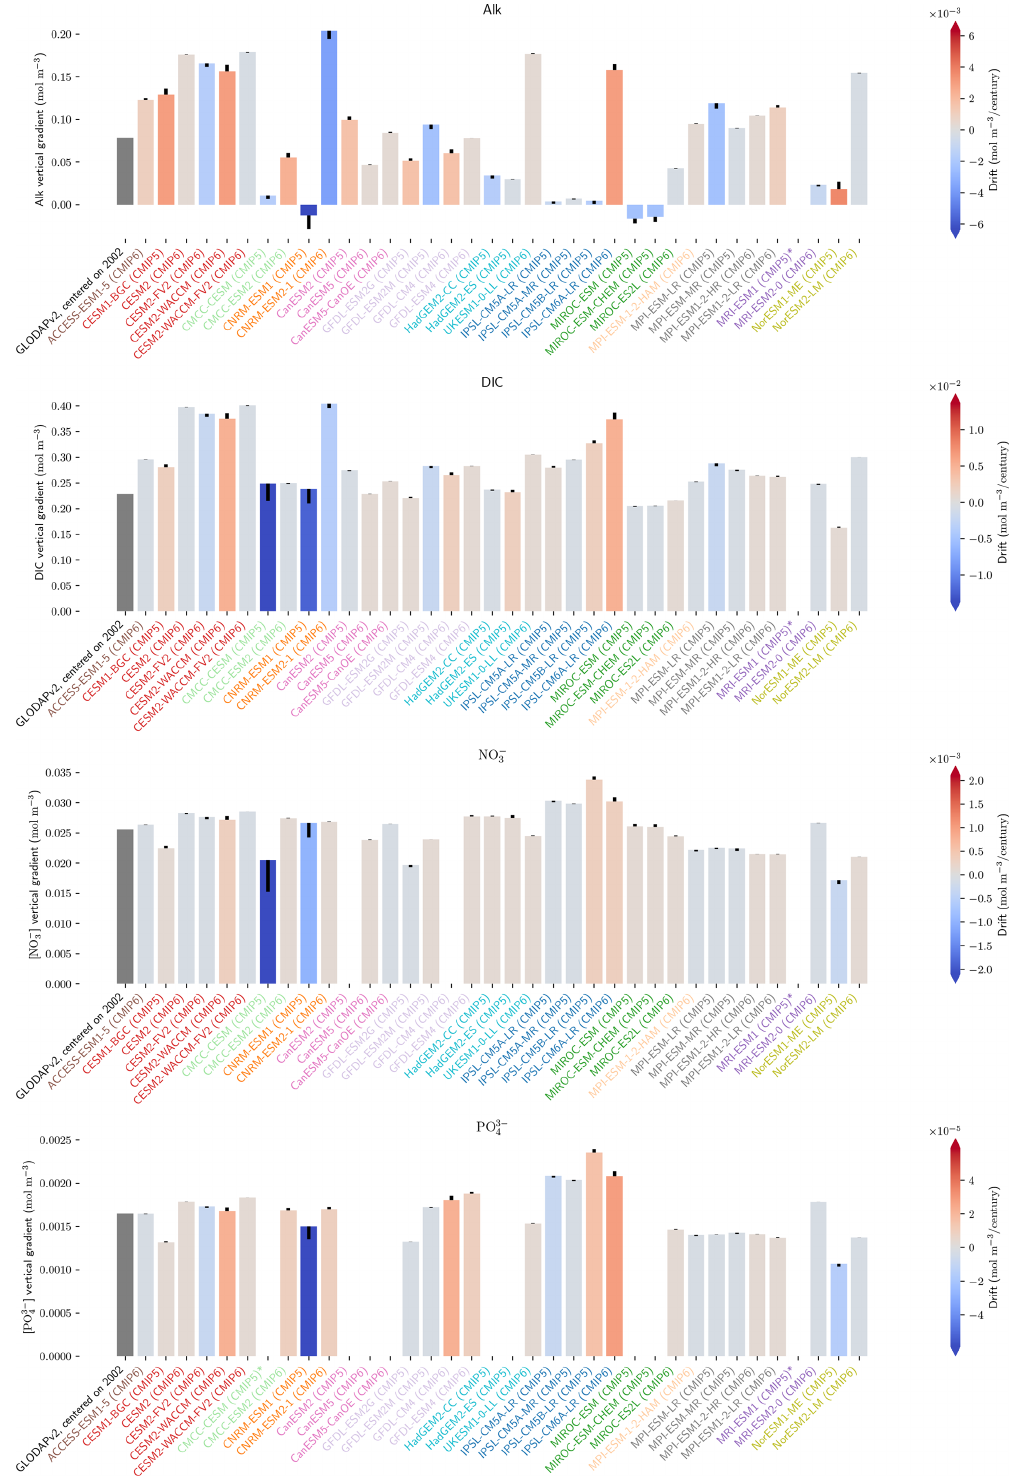
Figure D7. Additional CMIP5 and CMIP6 model drift evaluation. Drift in the global open-ocean vertical gradient (defined in Sect. 3.2.3) of Alk, DIC, nitrate and phosphate. For each panel, the first bar denotes the observations, bar height denotes the mean vertical gradient in the first 20 years of the piControl (corresponding to 1850–1870), and the extremity of the black bar denotes the mean vertical gradient in the last 20 years of the piControl (corresponding to ∼ 2080–2100). Bar colour denotes model drift per century. Model names with an asterisk are not shown due to extreme drift relative to other models. piControl data for MRI-ESM1 (CMIP5) and piControl nitrate data for CanESM2 (CMIP5) were not